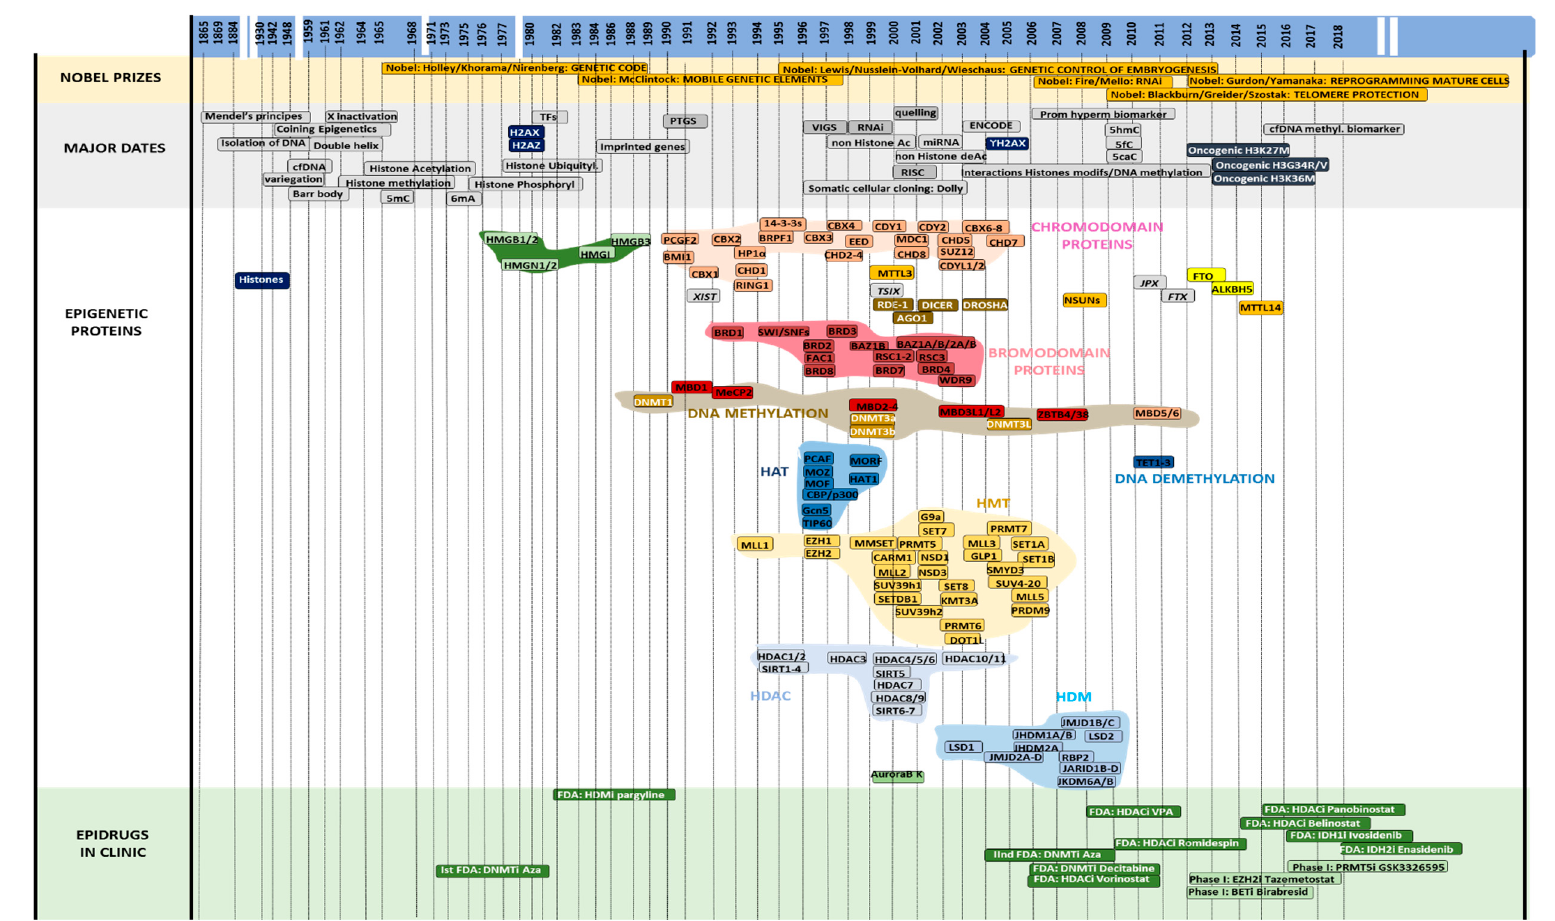
Figure 1. Chronology of epigenetics. From top to bottom: Dates (blue): from 1865 to today; Nobel Prizes (salmon) associated with major genetic or epigenetic discoveries; major dates (gray): important discoveries concerning DNA and chromatin; epigenetic proteins (white): year of identification or main writers, readers and erasers of epigenetics (a color code has been associated to proteins involved in a same pathway, e.g., blue for HAT (histone acetyl transferase)); epidrugs in the clinic (green): use of main epidrugs in clinical trials.